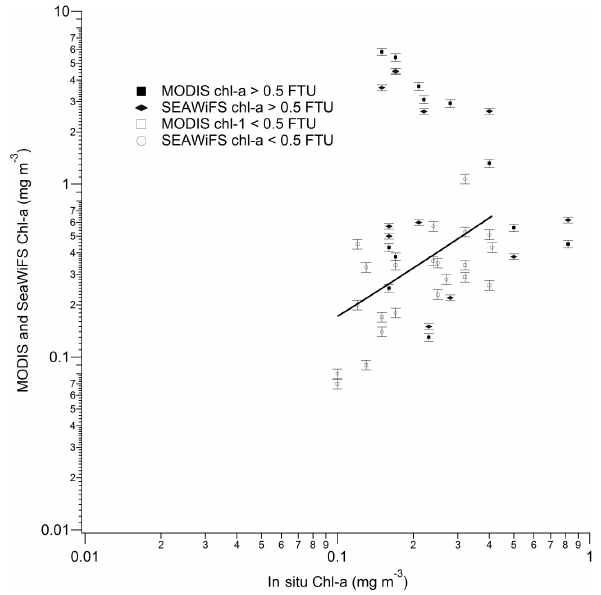
Figure 4. chl a concentrations from the satellite data plotted against in situ chl a . The solid symbols represent samples where turbidity was >0.5 FTU, and open symbols for turbidities <0.5 FTU. The line is a linear fit to the lower turbidity